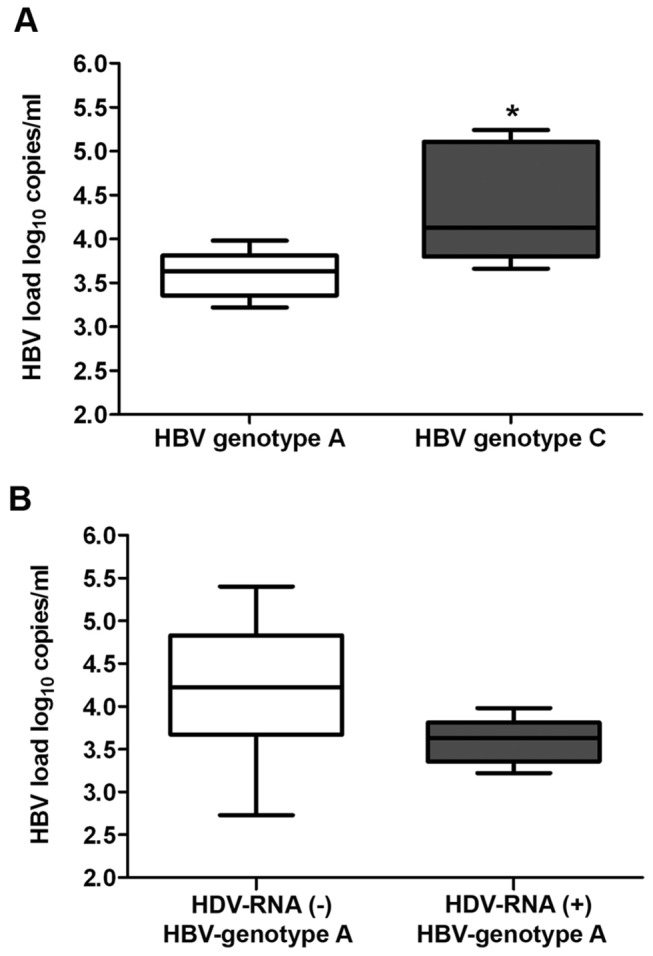
HBV replication of different HBV-genotypes in HBV/HDV coinfection.(A) Determination of HBV loads of the predominant HBV-genotype A and HBV-genotype C samples in the Vietnamese HDV-positive patients (*denotes p<0.05). (B) Comparison of HBV loads in the HBV-genotype A samples according to the status of HDV-coinfection. The HBV load was closely significantly lower in HDV-positive patients than HDV-negative patients (p = 0.053). p<0.05 is statistically significant.